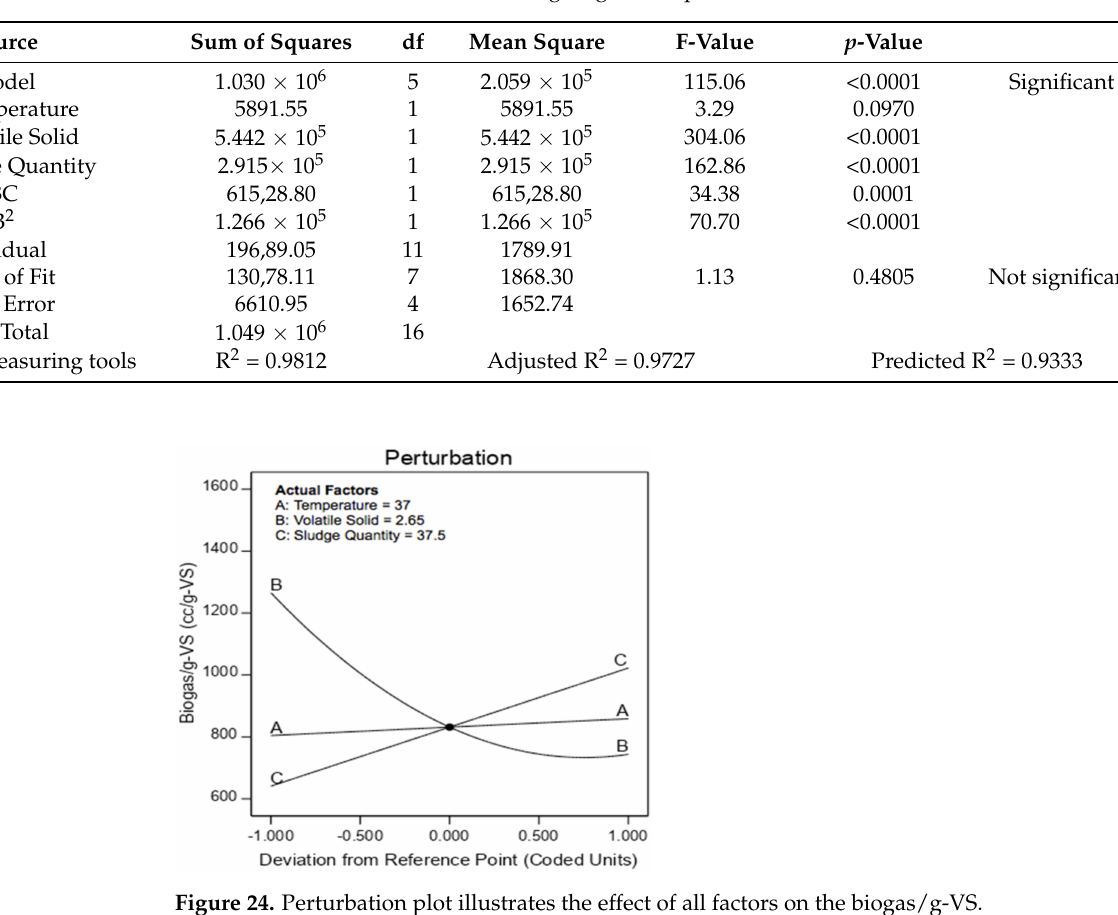
Table 9. ANOVA table for Biogas/g-VS Response.